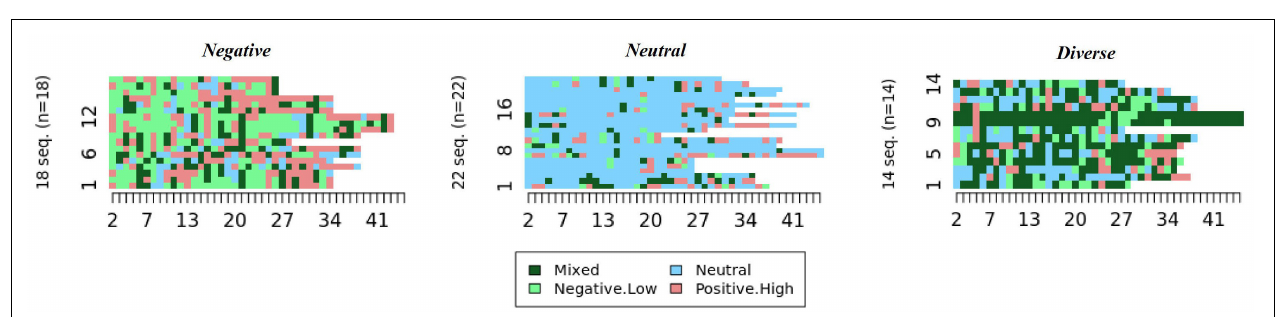
FIGURE 4 | Index plot of the sequences of the three clusters of students with discrete socio-emotional interaction profiles; each colored block represents a socio-emotional state, and each line signifies a distinct student.